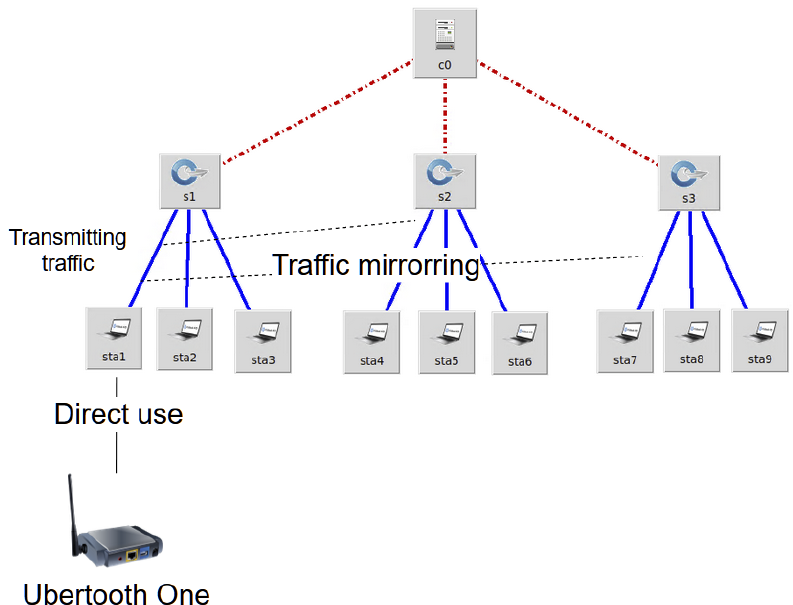
Figure 4. Design for parallel computations network topology using the Ubertooth One device. Algorithm 2 details the implementation process for processing data received from the Ubertooth One device.